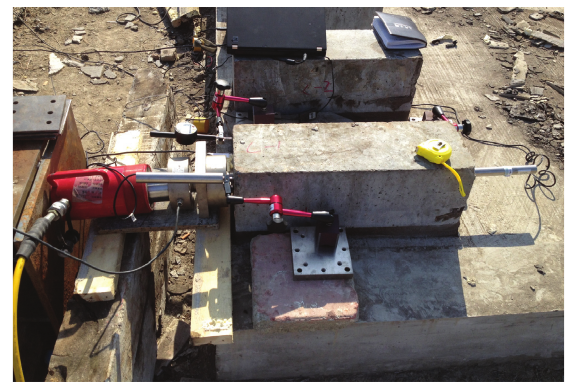
Figure 7: Setup of the scale horizontal push plate test.